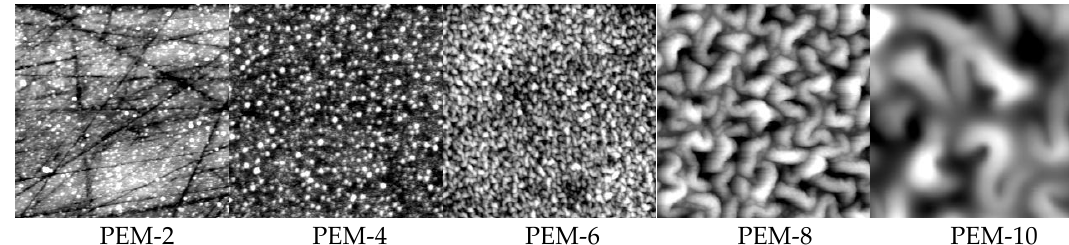
Figure 3 . ( a ) Thickness (left y -axis) and roughness (right y -axis) of the PEMs of PEI/PAA in relation to z obtained by dipping method and drying after each rinsing step with stirring (black circles) and without stirring (grey triangles). Roughness values (RMS) are included for the stirring case (open Figure 4. SFM images (topography, 4 × 4 µ m) on PEM-2, -4, -6-, 8-, and 10 (from left to right) of PEI / PAA Figure 4. SFM images (topography, 4 × 4 μ m) on PEM-2, -4, -6-, 8-, and 10 (from left to right) of circles). ( b ) Mass per area m / a (black cubes, left y -axis) and IR band integral (transmission mode, deposited by the dipping method (stirring) from 0.005 M solutions at pH = 10 / PEI/PAA deposited by the dipping method (stirring) from 0.005 M solutions at pH = 10/4. open circles, right y -axis) of the PEMs of PEI/PAA in relation to z obtained by the dipping method with stirring and drying after each rinsing step.